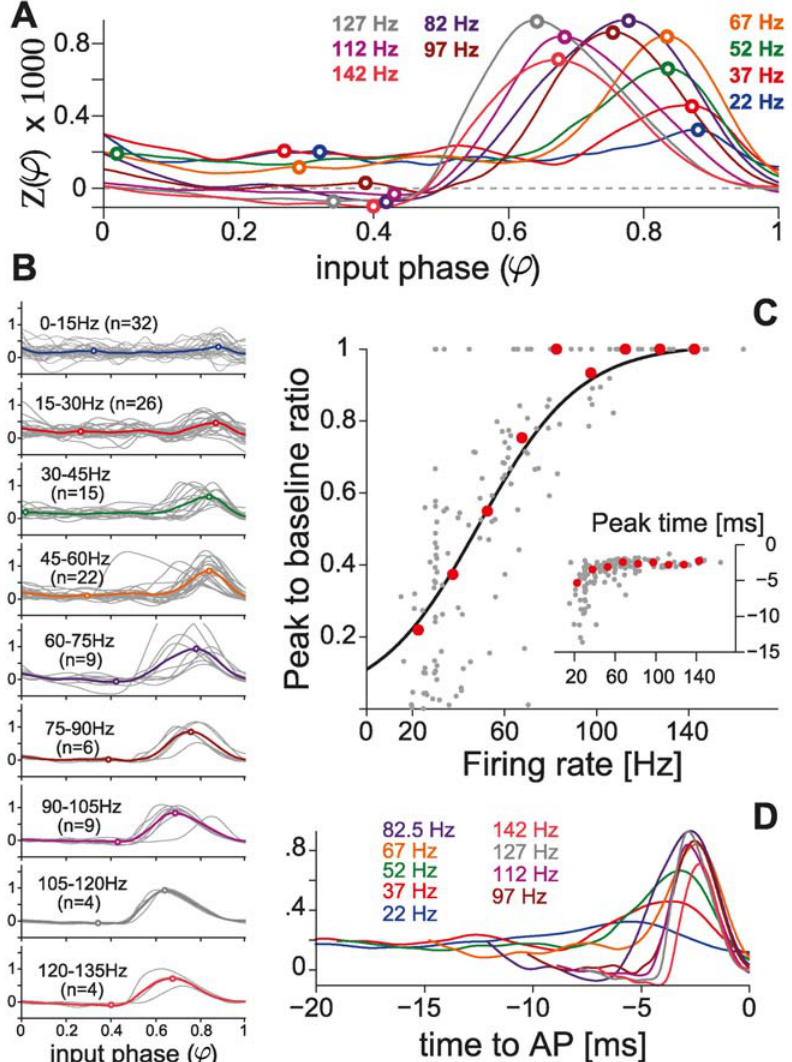
Fig 3. Population summary using the direct method. (A) Population summary obtained over distinct firing rates, by averaging PRCs across individual cells. (B) Individual responses are plotted in gray and pooled according to the corresponding firing rate. Cell numbers are further indicated in parentheses. This summary, quantified by the peak-to-baseline ratio as in Fig. 2C (individual cells, n = 42: gray markers; averages from A: red markers), confirms (C) our observations in single PCs (Fig. 2). The black curve represents the function (1 + e − ( F − a )/ b ) − 1 , with best-fit parameters a = 47.6, b = 21.7 optimized over the set of 42 PCs. The inset further displays the location of the summary PRCs peak, relative to the time of the AP following the stimulus (i.e., τ peak = ( φ peak − 1) (cid:1) h ISI i ), as in Fig. 2B. (D) The average PRCs are equivalently represented as a function of time (i.e., τ = ( φ − 1) (cid:1) h ISI i ) for the 20 ms preceding the perturbed